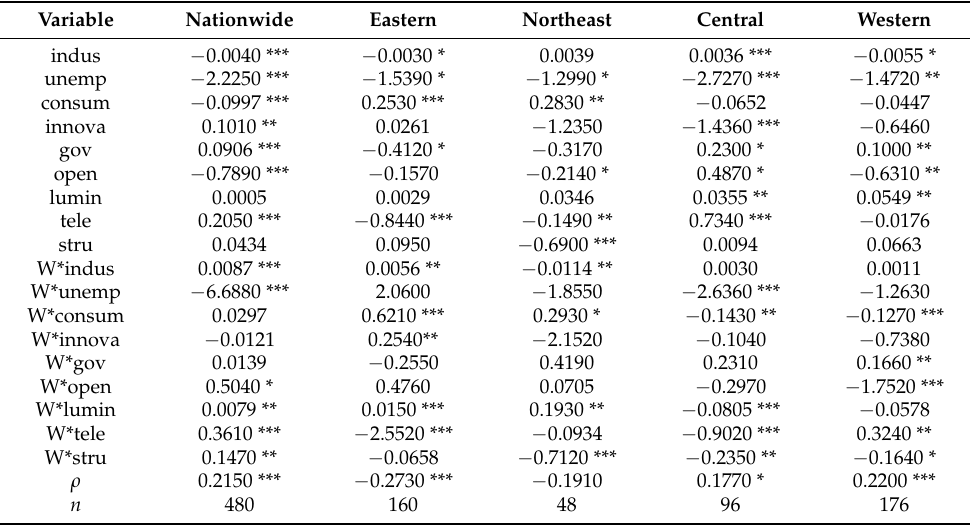
Table 7. Robustness test results of the spatial weight matrix based on the geographical